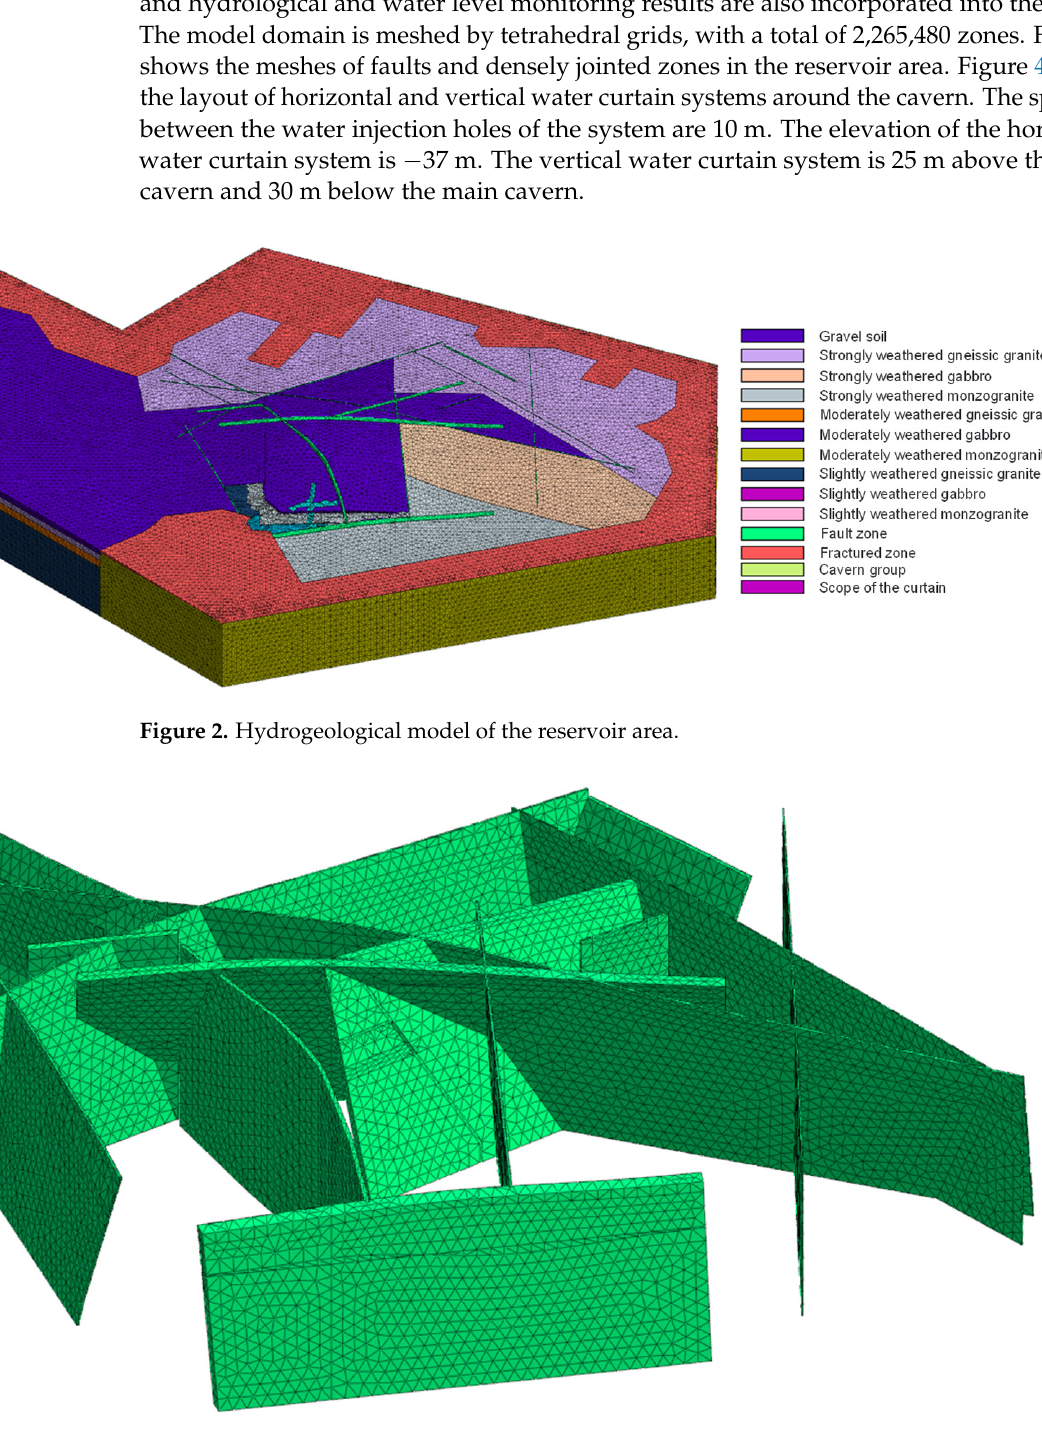
Figure 3. Finite element mesh of faults and joint dense zones.